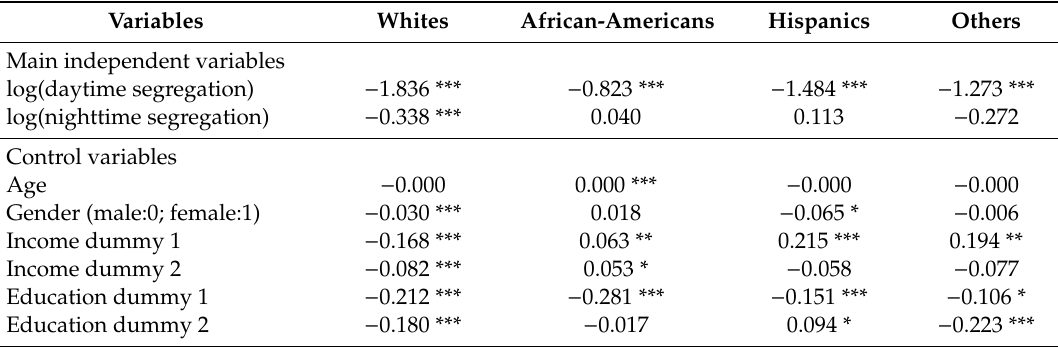
Table 3. Race-specific regression analysis